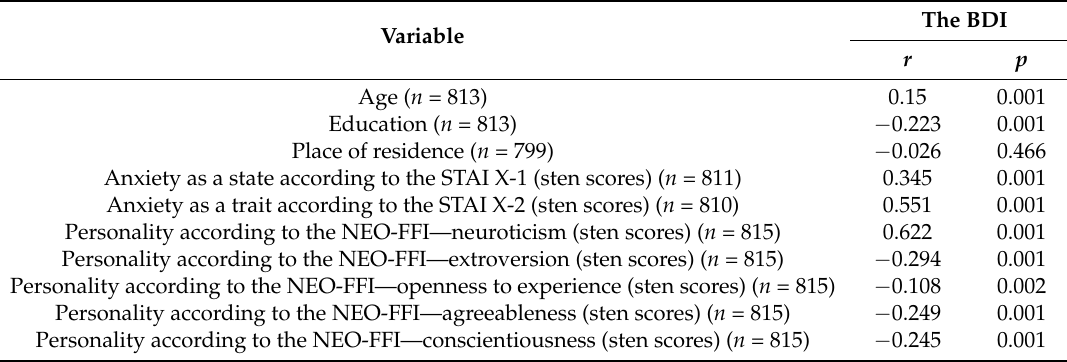
Table 4. Pearson’s linear correlations between the Beck Depression Inventory (BDI) results and selected